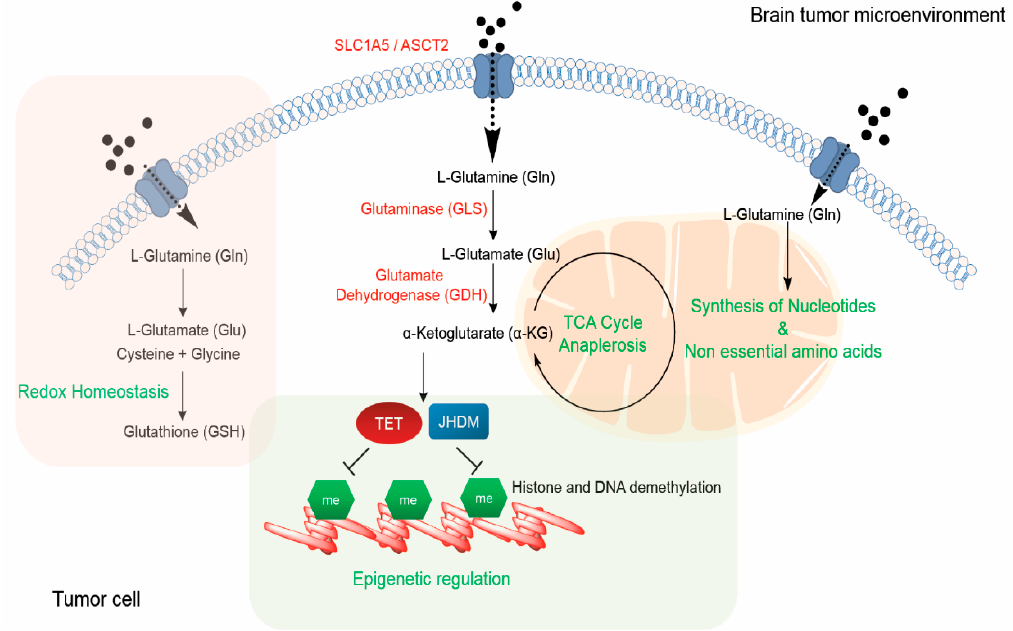
Figure 3. Functional roles of glutamine in regulating tumor progression. Glutamine from the brain tumor microenvironment is taken up by tumor cells via ASCT2/SLC1A5 and converted into glutamate by the enzyme, glutaminase (GLS). Glutamate, along with cysteine and glycine, can be utilized by the tumor cell to synthesize glutathione (GSH), which is pivotal for maintaining redox homeostasis. Glutamate dehydrogenase (GDH) converts glutamate to α -ketoglutarate ( α -KG), which drives TCA cycle anaplerosis. Glutamine metabolism can influence the tumor cell epigenome and methylome by modulating the levels of α -KG, which is an important co-factor for DNA (TET) and histone demethylases (JHDM). Additionally, glutamine plays a key role in mediating synthesis of nucleotides and other non-essential amino acids. Abbreviations: TCA, tricarboxylic acid; TET, Tet methyl cytosine dioxygenase; JHDM, Jumonji domain-containing histone demethylase.